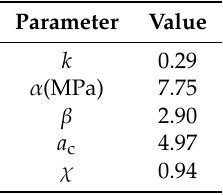
Table 2. Hydrate-related